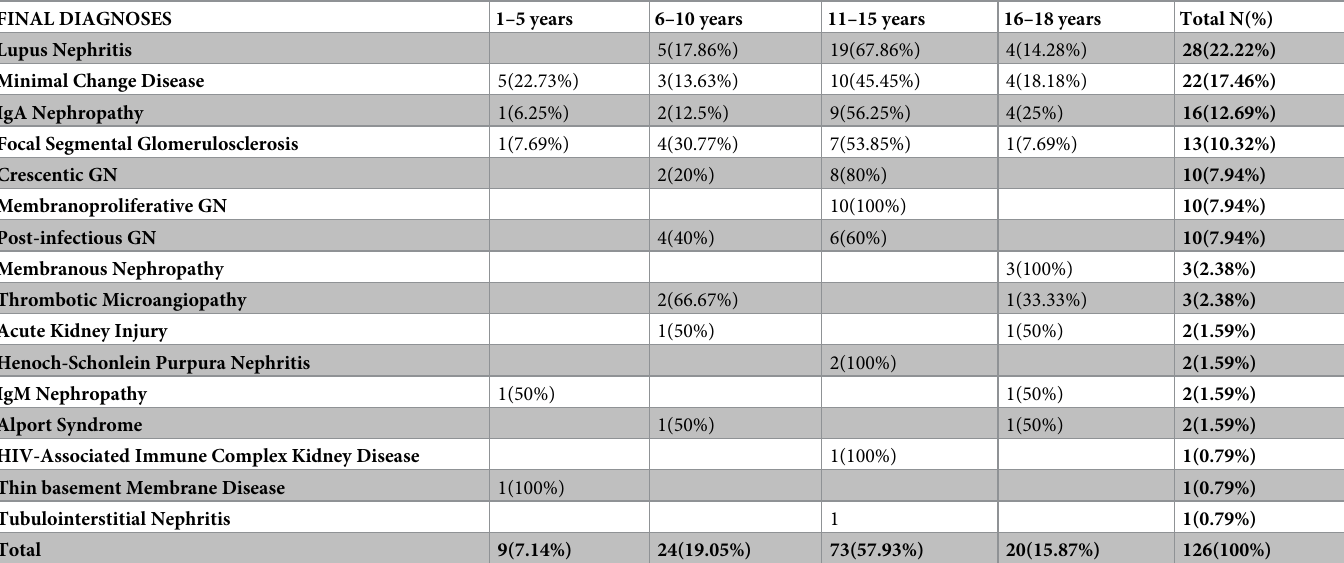
Table 2. Age wise histopathological diagnoses (N = 126).